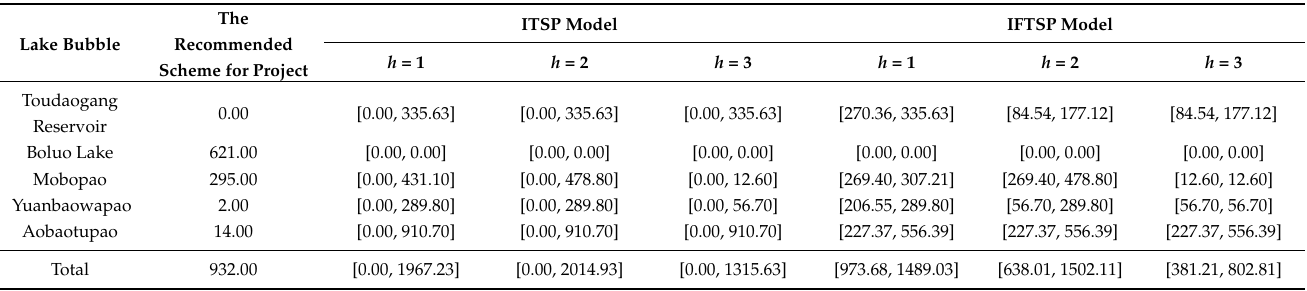
Table 4. Comparison between IFTSP and ITSP model optimisation schemes for flood diversion volumes of each of the lake bubbles in Boluo Lake under different scenarios.